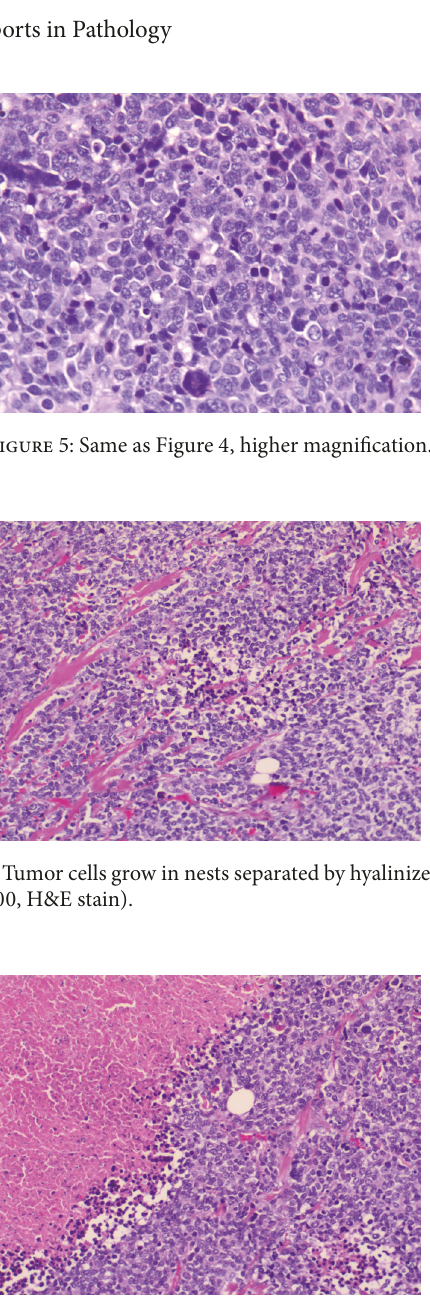
Figure 7: Tumor cells with extensive necrosis (H&E, X200).